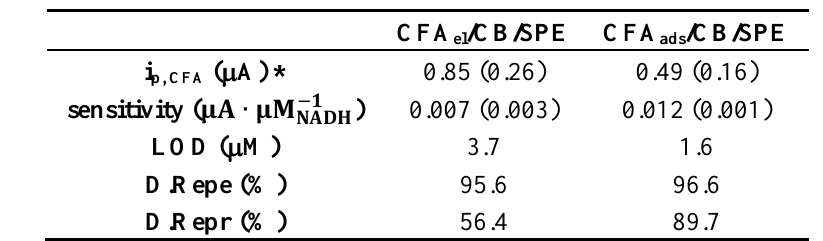
Table 1. Performance of CFA/carbon black (CB)/screen-printed electrodes (SPEs) toward NADH determination calculated from amperometric measurements at a +0.25 V constant potential; the relevant standard deviation, calculated by considering three similar SPEs, is reported within